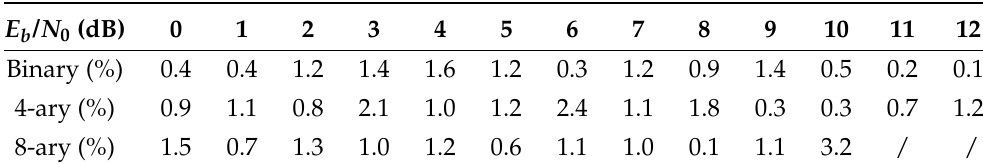
Table 2. The errors between the BER performance and the theoretical results of suboptimal receiver (100 × 10 5 PPM symbols).